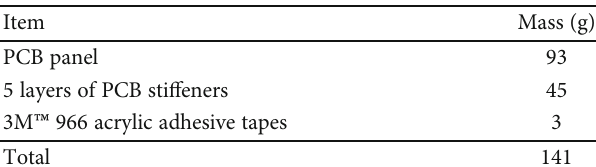
Table 2: Mass budget of the demonstration model of the solar